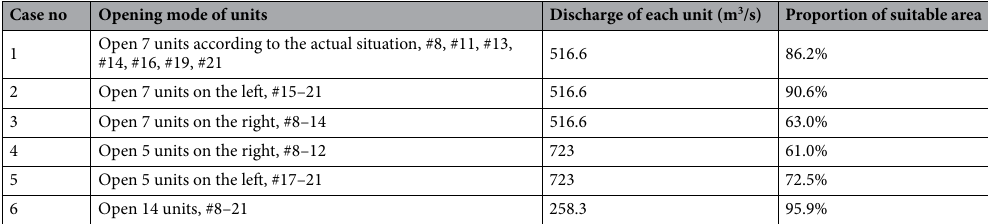
Table 1. Calculation cases with different opening modes of units under the identical